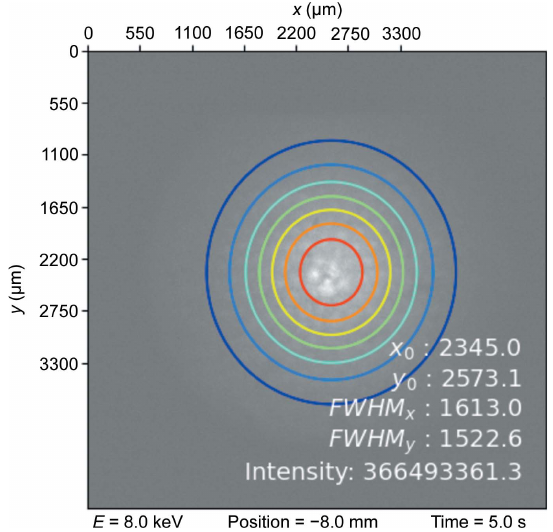
Figure 13 Fitted multivariate normal distribution